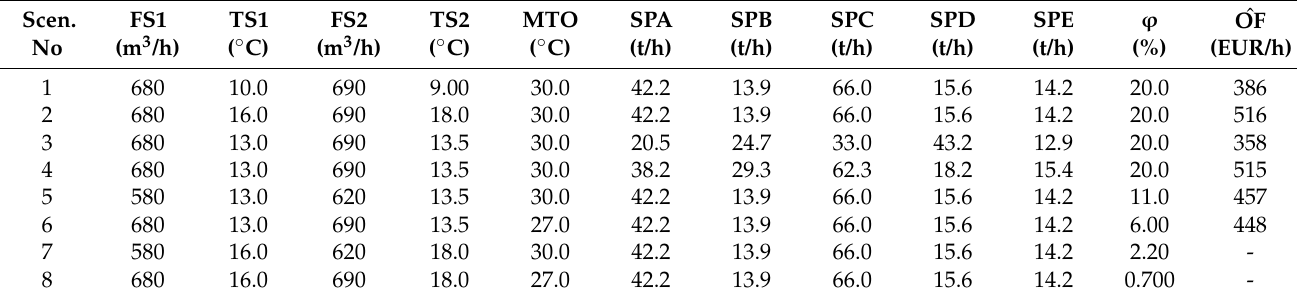
Table 2. Scenarios defined according to expected operating conditions. Most probable values are in plain text whilst the less probable ones are colored in red.